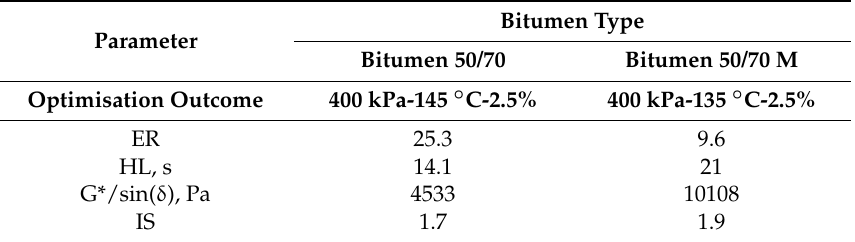
Table 9. Comparison of bitumen foam optimisation results with regard to the